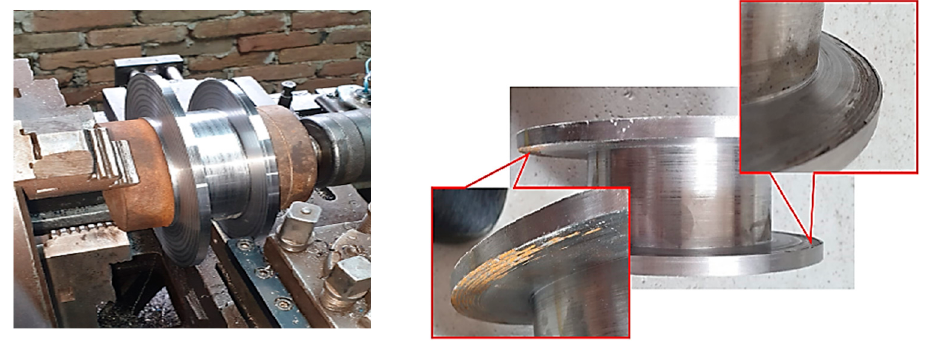
Figure 9. Shaping the piece.